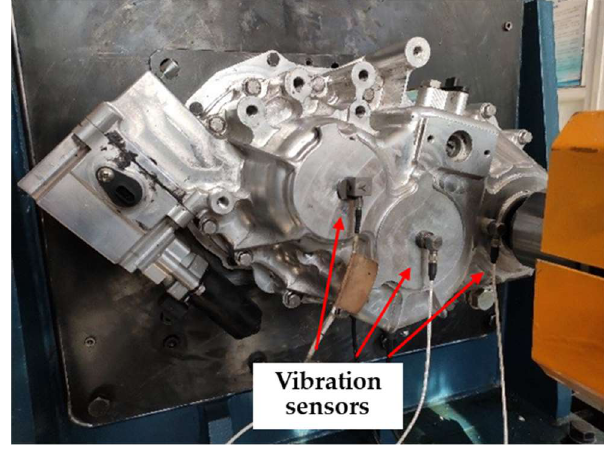
Figure 5. Arrangement of vibration sensor.